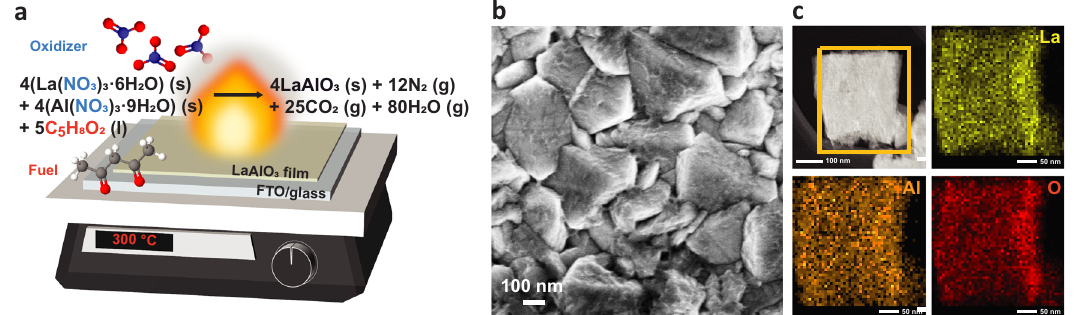
Fig. 3 | Solution combustion synthesis process and characterizations of the fi nal product. a Schematic of low-temperature solution combustion processing